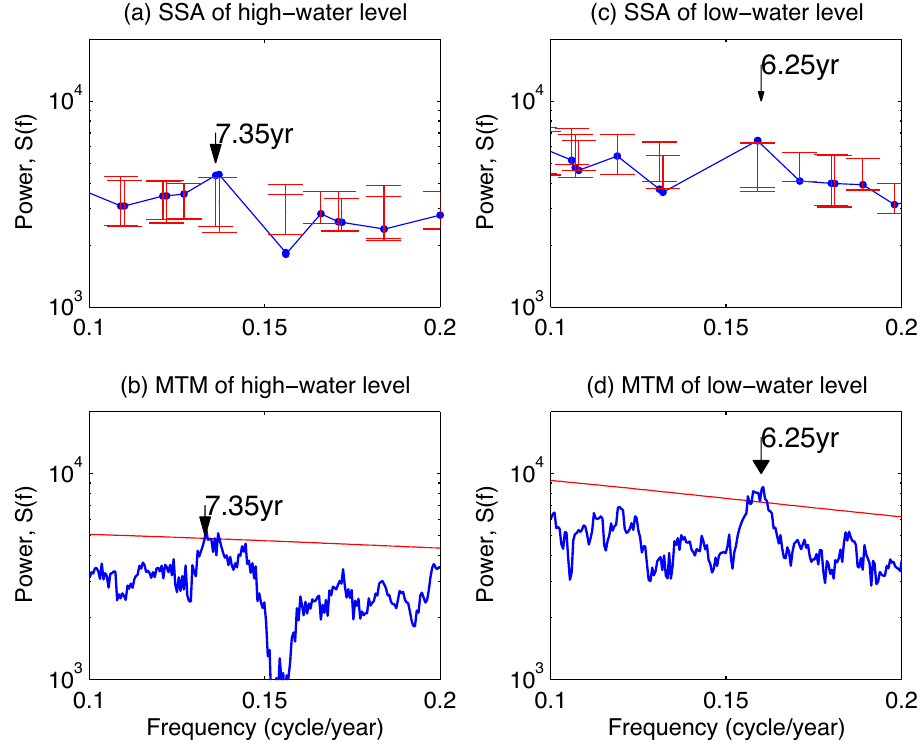
Fig. 5. Mean exceedance time < k > for the deterministic system in Fig. 4a (solid line). The dashed line stands for the prediction of classical EVT theory. From Nicolis and Nicolis (2007).